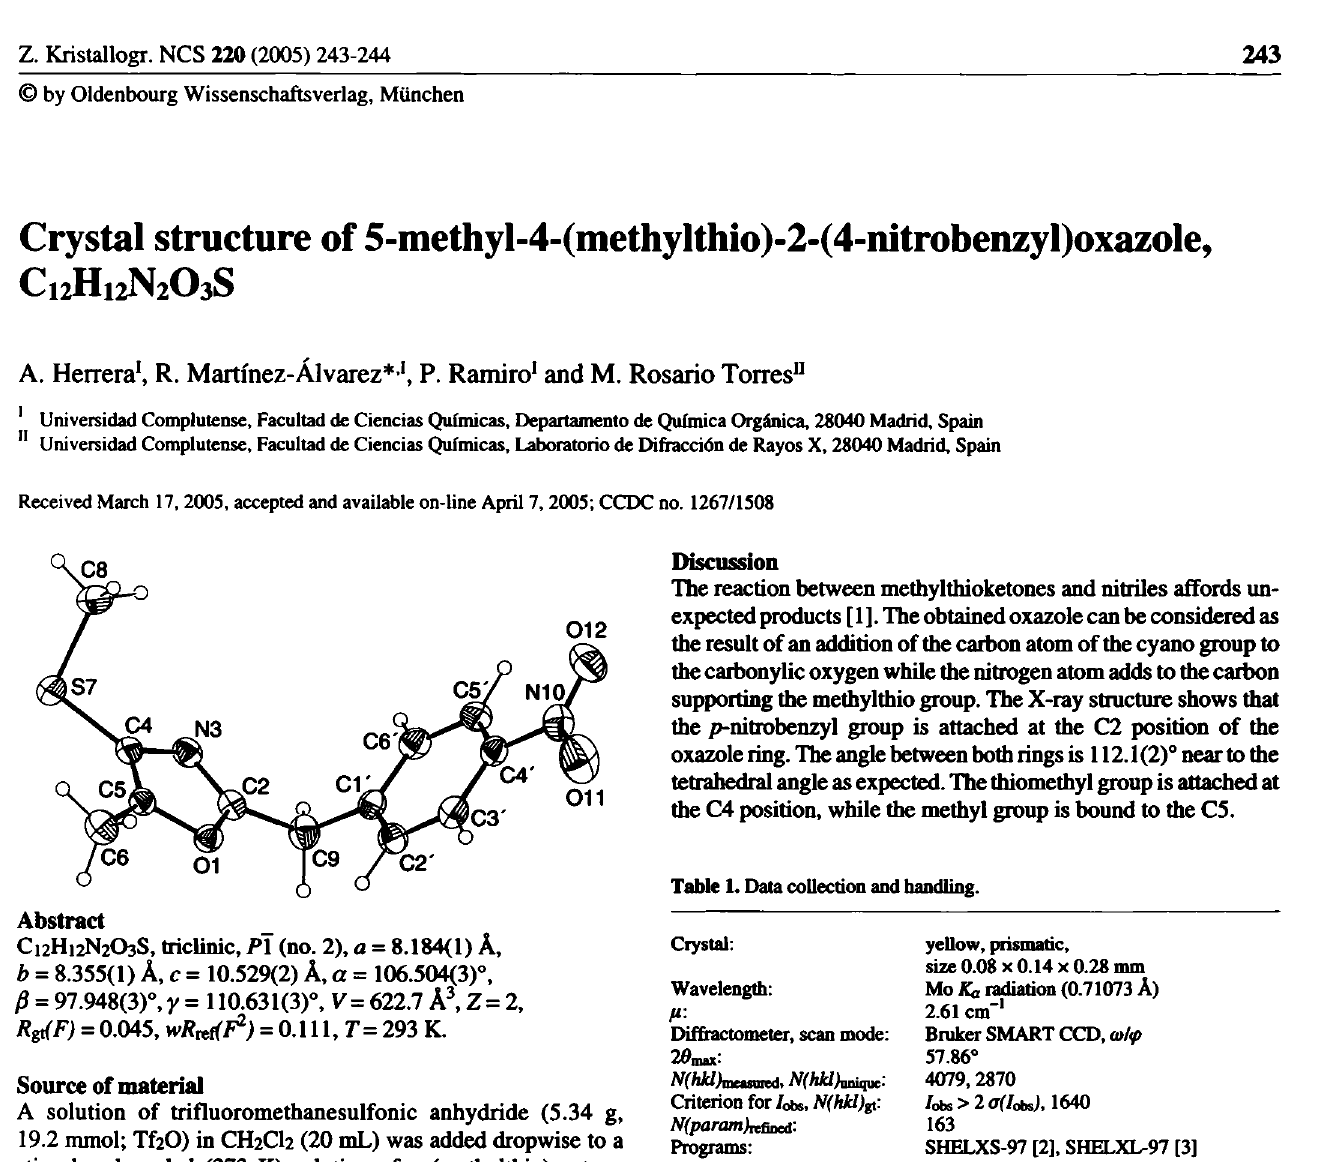
Table 2. Atomic coordinates and displacement parameters (in A 2